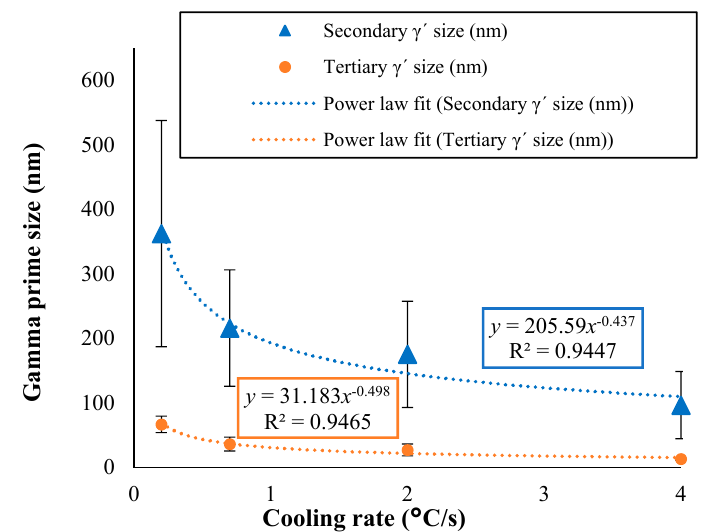
Figure 4. The variation in secondary and tertiary γ′ mean precipitate size with the cooling rate.